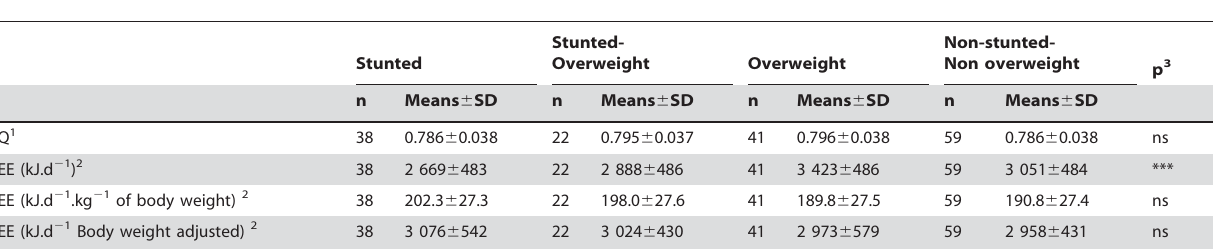
Table 2. Respiratory quotient (RQ) and resting energy expenditure (REE) of subjects.